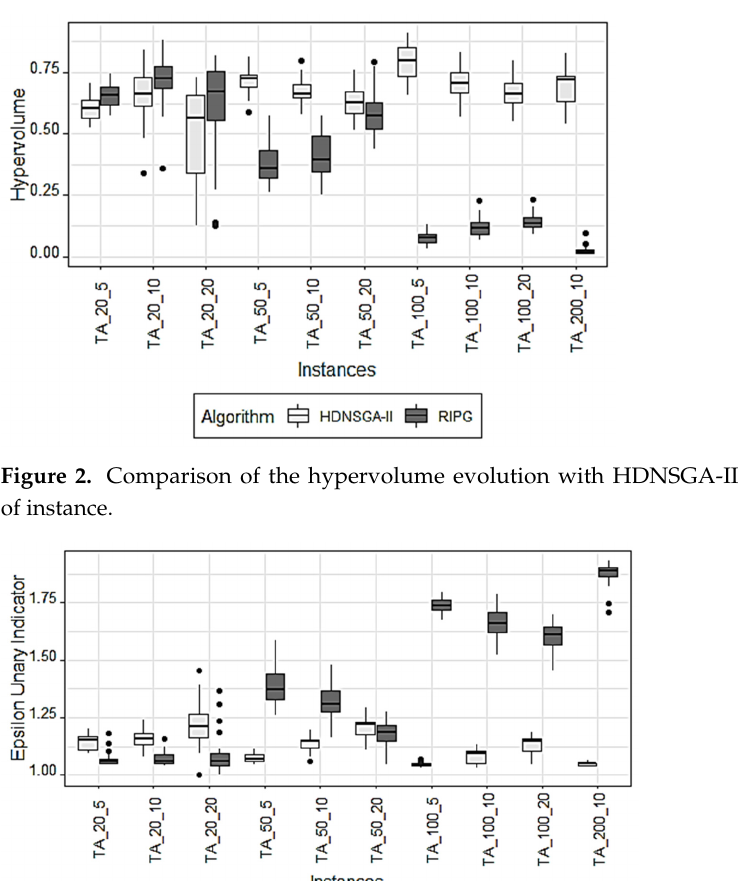
Figure 3. Comparison of the Epsilon unary indicator evolution with HDNSGA-II and RIPG in each type of instance.